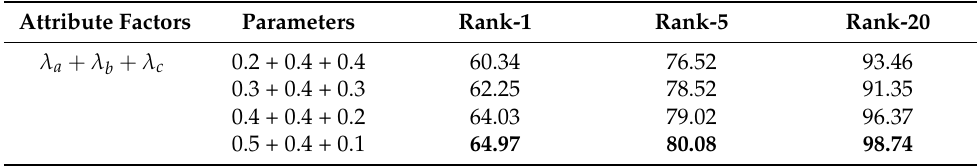
Table 7. The attribute factors learning on VIPeR